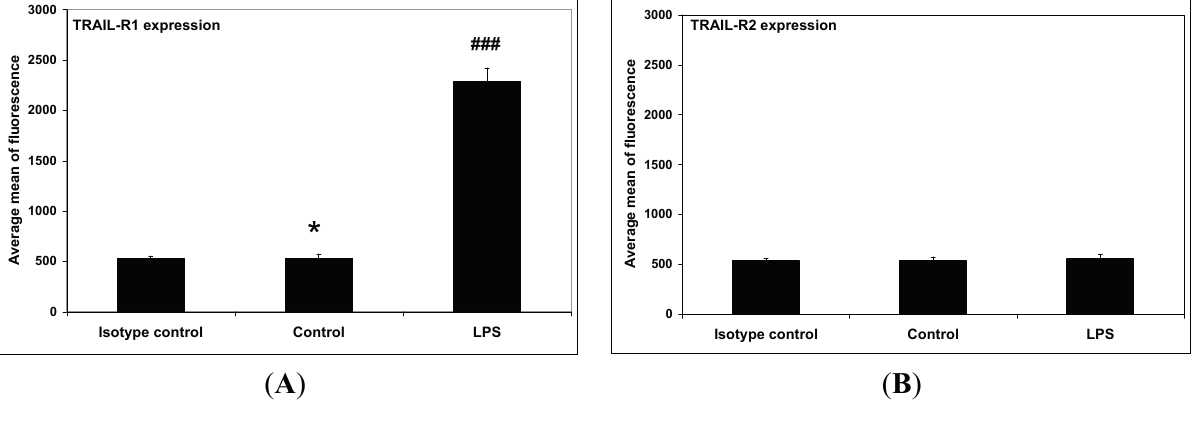
Figure 5. ( A ) Effects of flavones on TRAIL-R1 expression in RAW264.7 cells; Cells were incubated with LPS (200 ng/mL) ( B ); with LPS and chrysin ( C ); apigenin ( D ) and acacetin ( E ) at concentration of 20 μ M. The surface expression of TRAIL-R1 death receptor was measured by flow cytometric analysis. Representative histograms depict the average mean of fluorescence from three independent experiments performed in duplicate n = 6. *** p < 0.001 compared to isotype control. ### p < 0.001 compared to LPS-stimulated